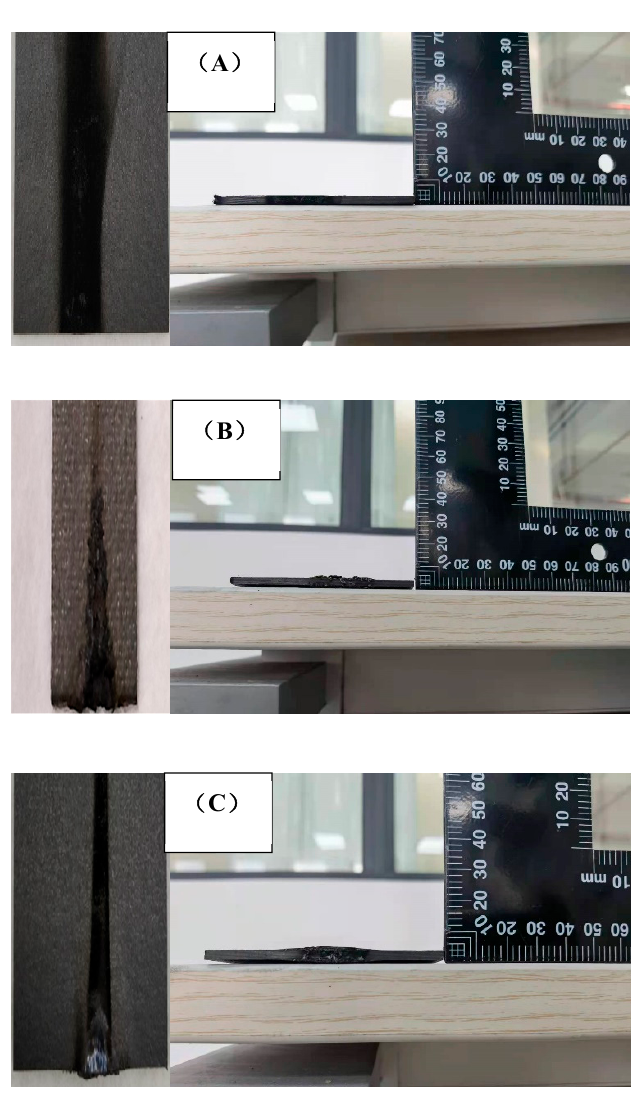
Figure 4. The images of the sample after the vertical burner test: ( A ) Laminate 1; ( B ) Laminate 2; ( C ) Laminate 3.